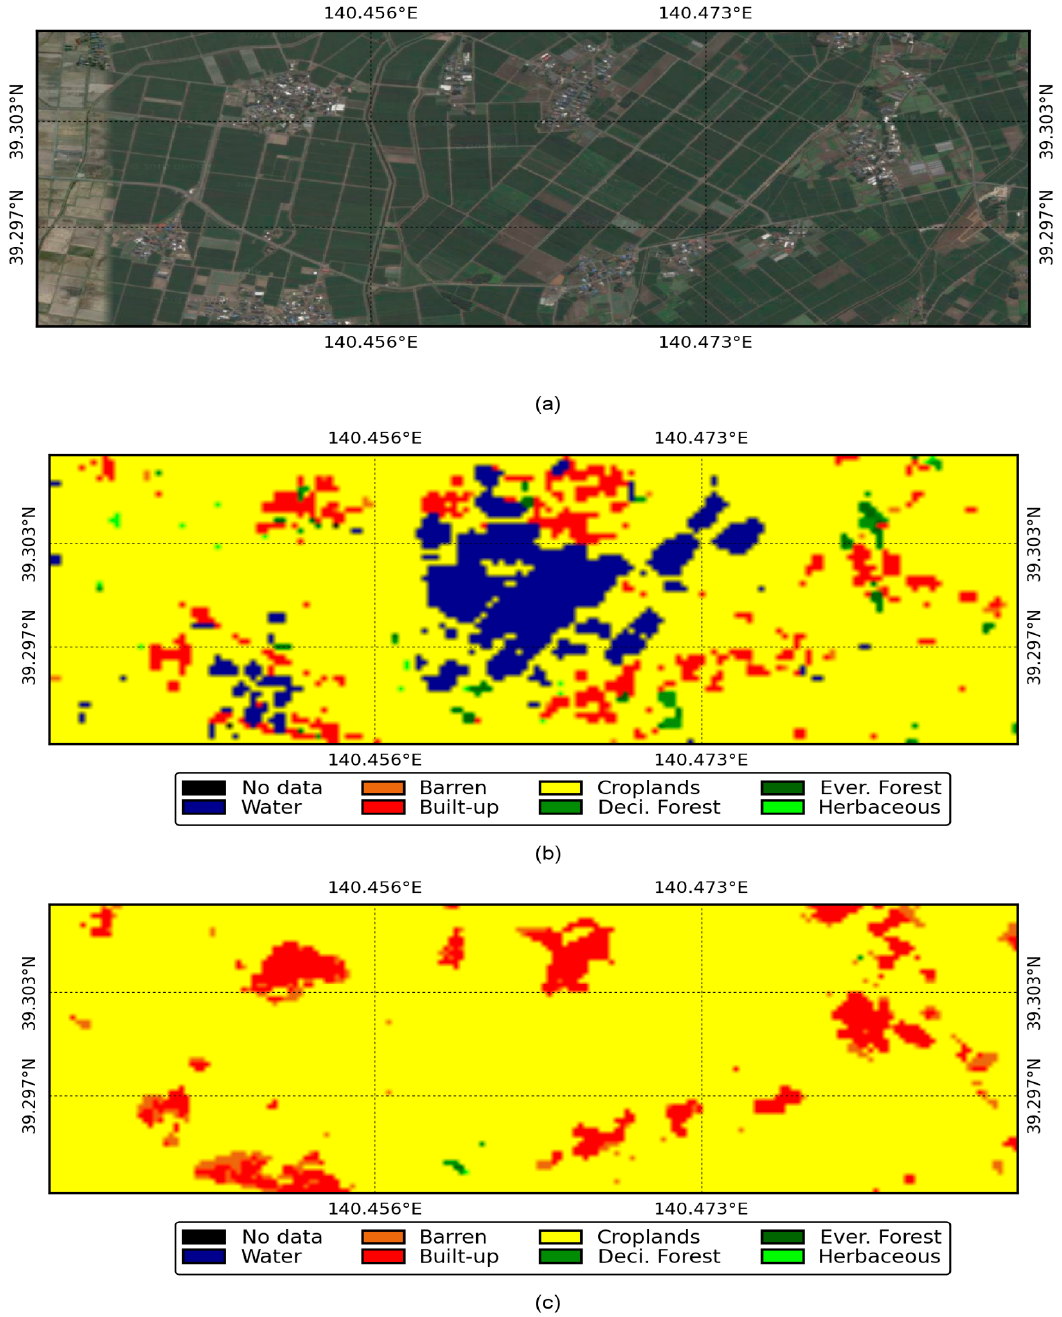
Figure 14. Performance of the JpLC-30 map over the JHR LULC map: ( a ) Google Earth™ image; ( b ) JHR LULC map; ( c ) JpLC-30 map.